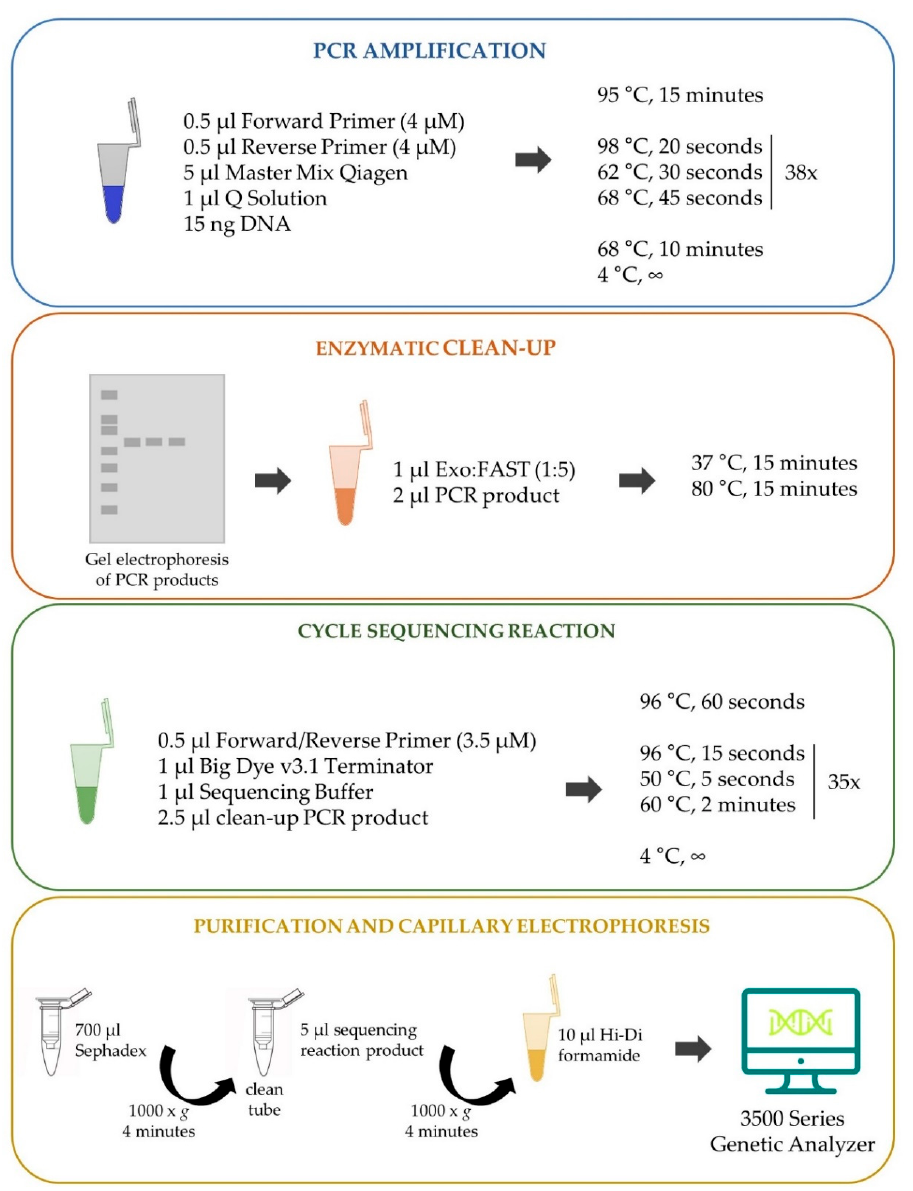
Figure 2. Schematic representation of the optimized protocol for Apolipoprotein E ( APOE ) genotyping.